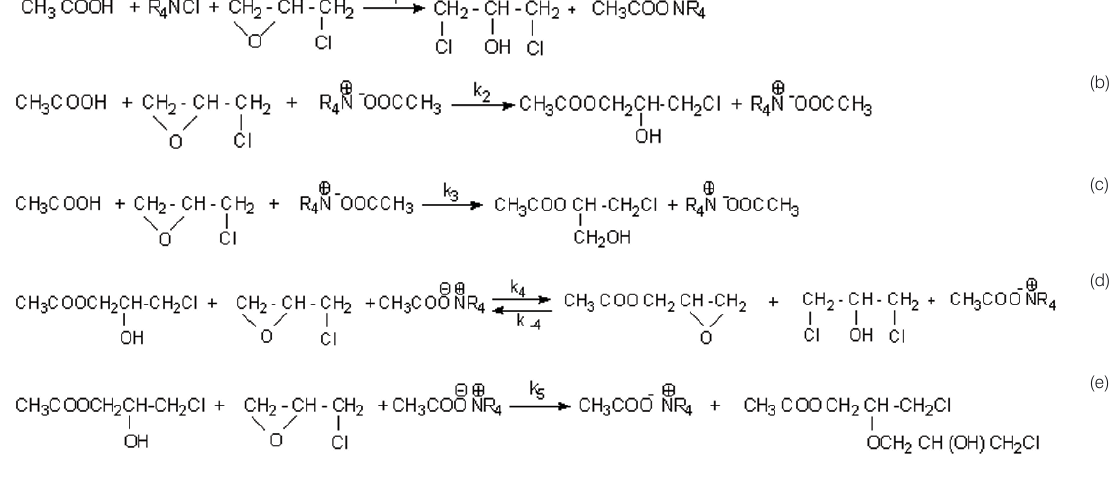
Scheme 2. Possible reaction mechanisms.